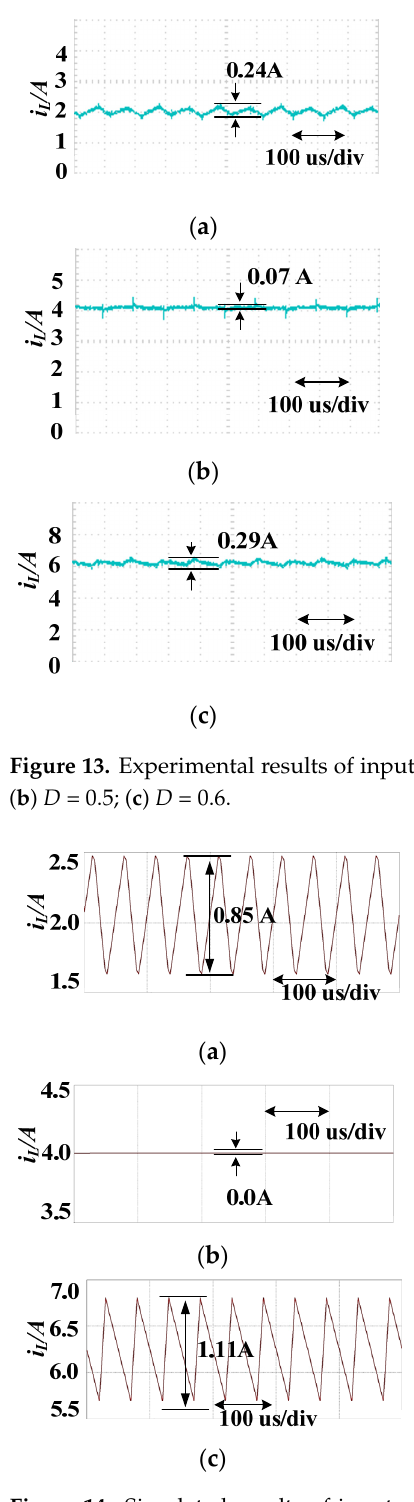
Figure 14. Simulated results of input current ripple characteristics of parallel circuit. ( a ) D =0.3; ( b ) D = 0.5; ( c ) D = 0.6.